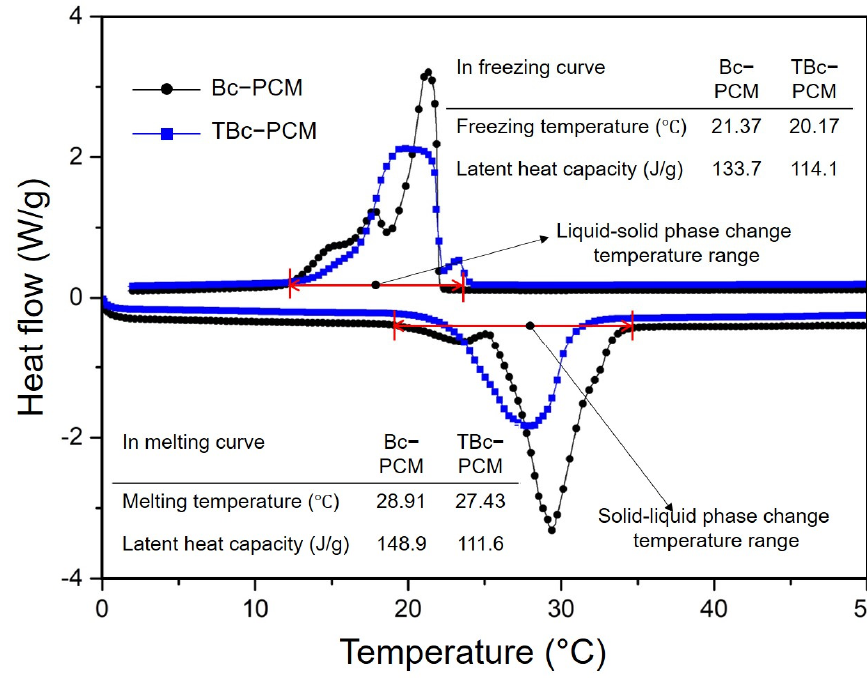
Figure 3. Heat storage analysis of Bc − PCM and TBc − PCM.